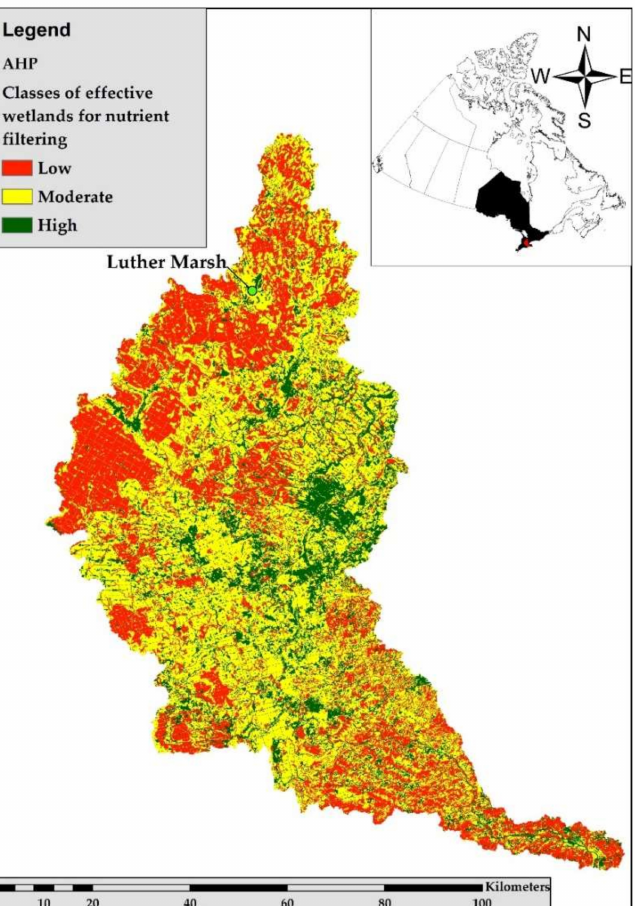
Figure 3. Final map with areas that could support e ff ective wetlands for nutrient